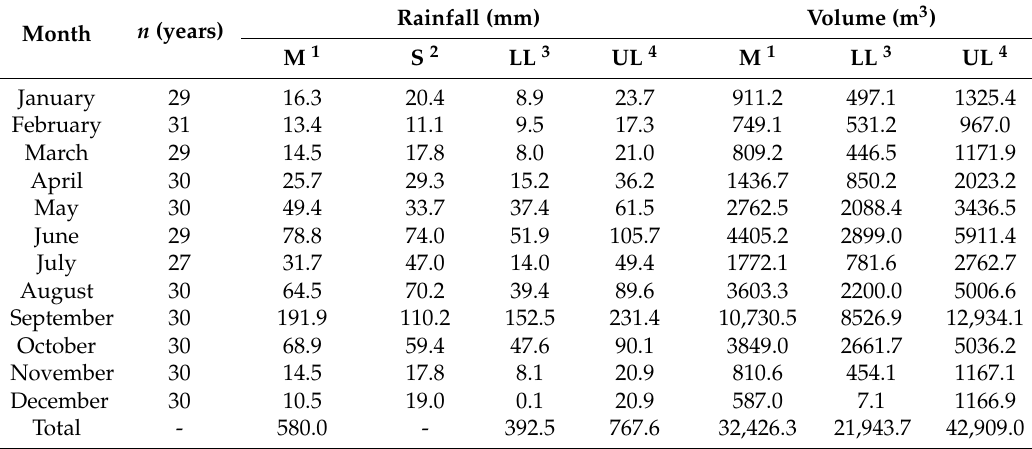
Table 1. Monthly rainfall and rainwater volumes for a confidence interval with a significance level of 95%.